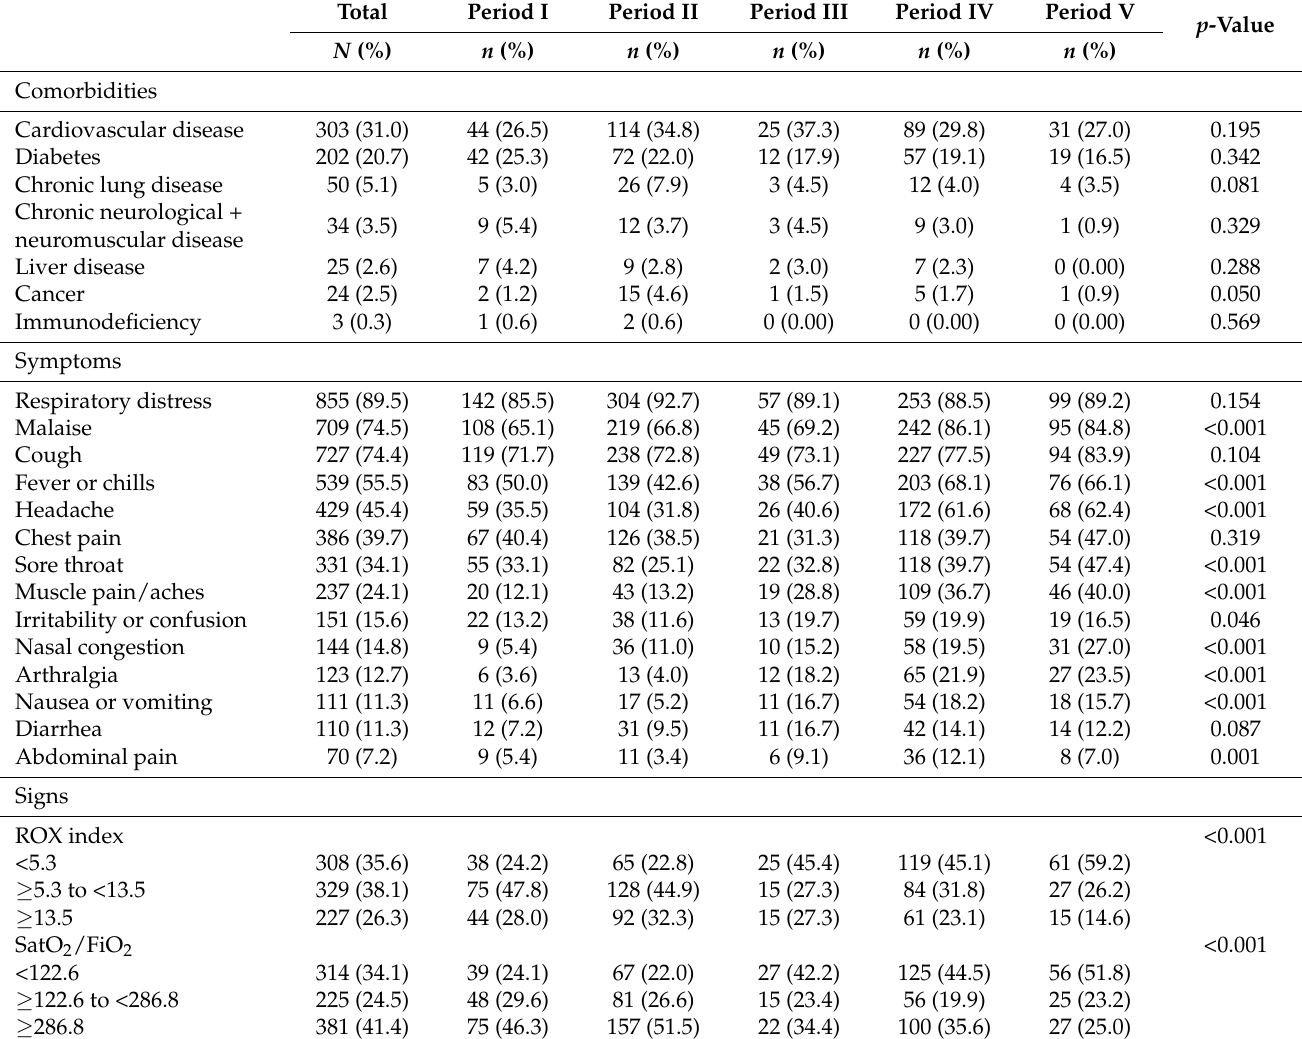
Table 3. Clinical characteristics of subjects who died due to COVID-19 at hospital